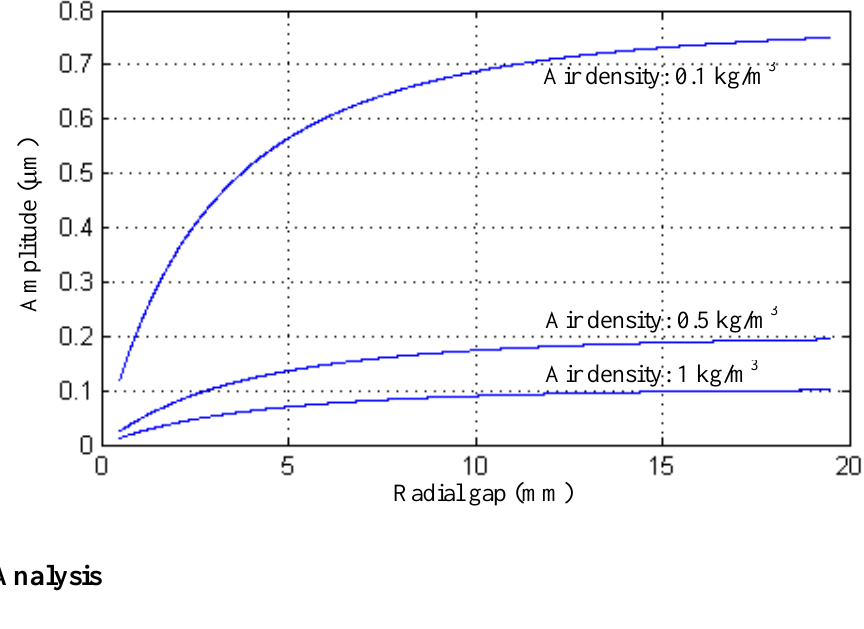
Figure 3. The amplitude including the consideration of structure-acoustic coupling